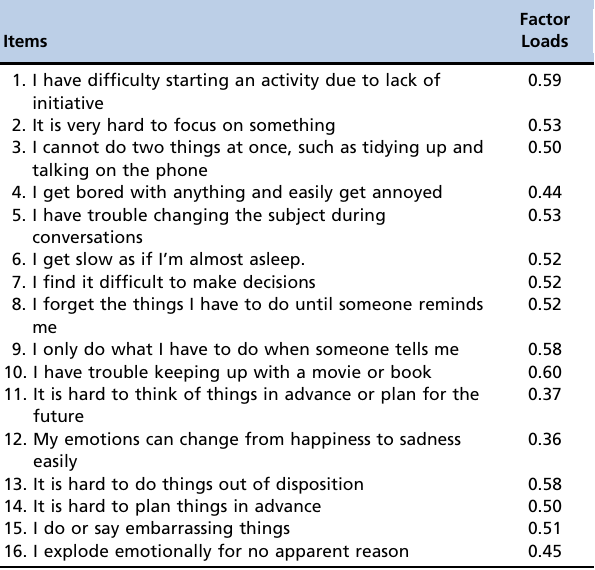
Table 3 - Factorial loads for Prefrontal Systems Inventory items (n=256).